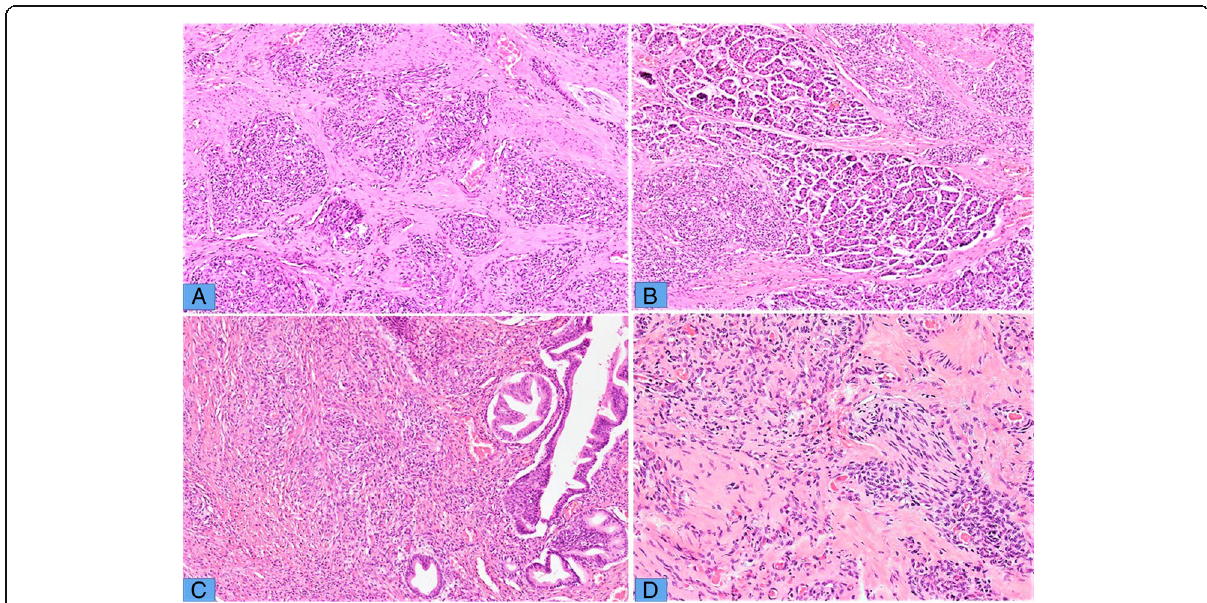
Fig. 1 Pancreatic KHE. a H&E stained sections of tumor showing predominantly glomeruloid arrangement in this field. These glomeruloid nodules are composed of closely packed vascular channels lines by single layer of bland endothelial cells. b This area shows predominantly spindle cell growth, infiltrating into the pancreatic acini. These areas resemble KS. c Other areas of spindle cell growth surrounding lining of a pancreatic duct, where the spindled endothelial cells grow in sheets with slit like lumina containing variable number of erythrocytes. d Focus of perineurial invasion